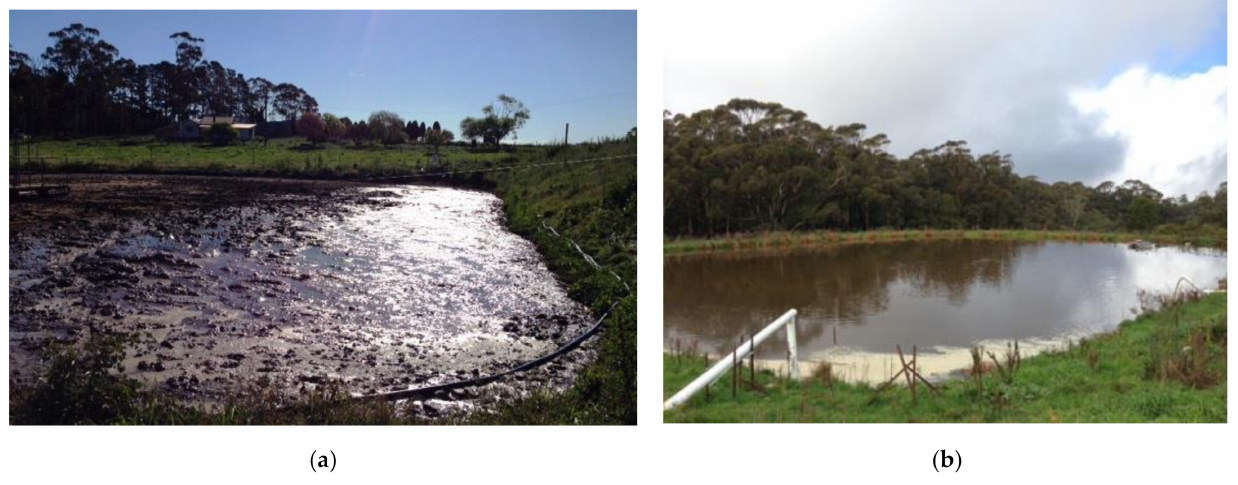
Figure 4. Pond system at the dairy farm: ( a ) Primary pond, ( b ) Secondary